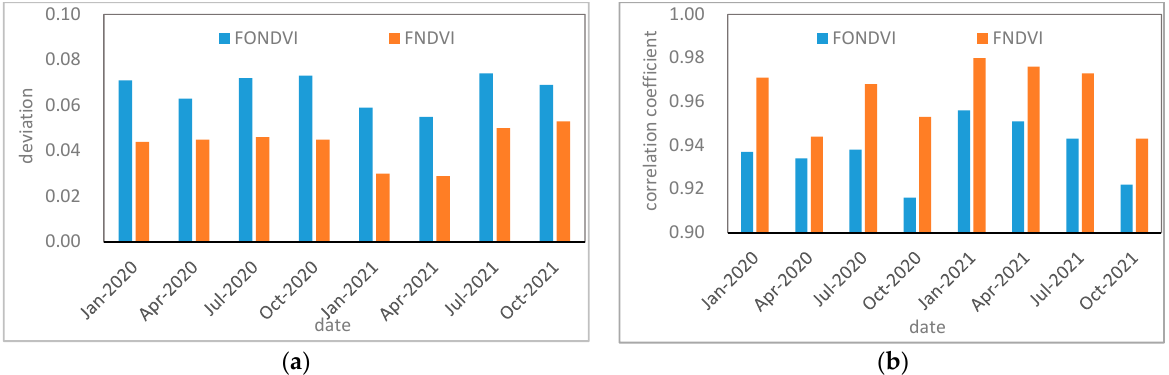
Figure 10. Comparison of the average absolute deviation ( a ) and correlation coefficient ( b ) between FONDVI and FNDVI products relative to MNDVI.